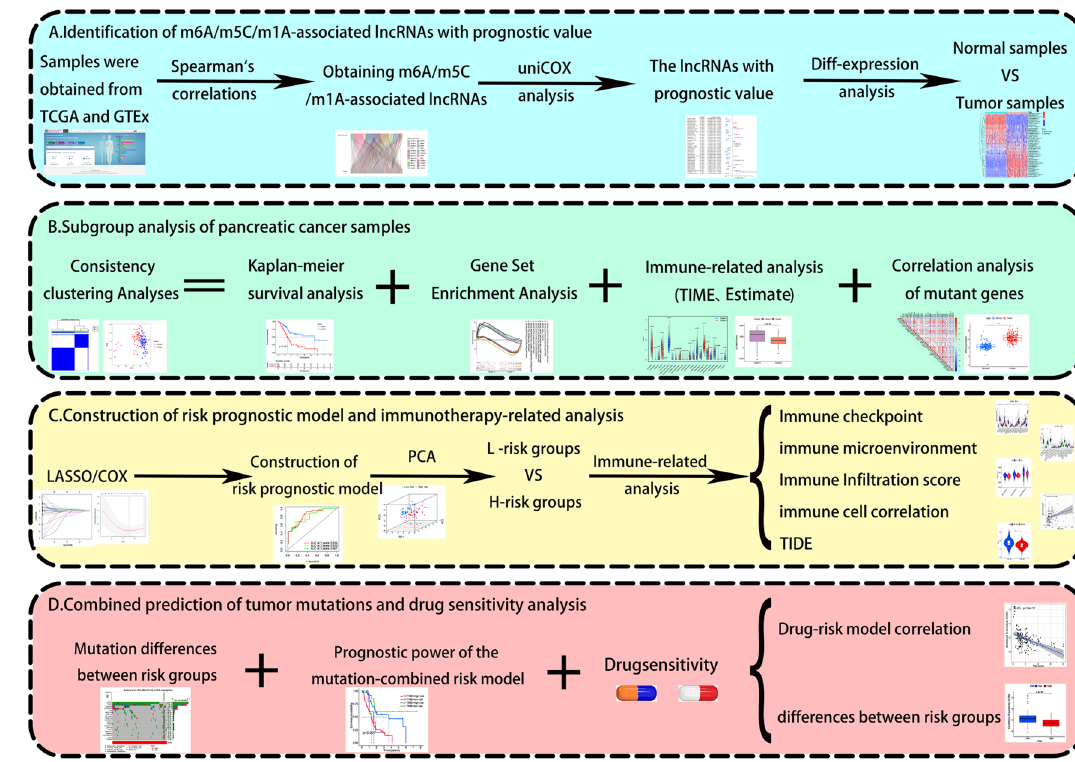
Figure 1. Study flow